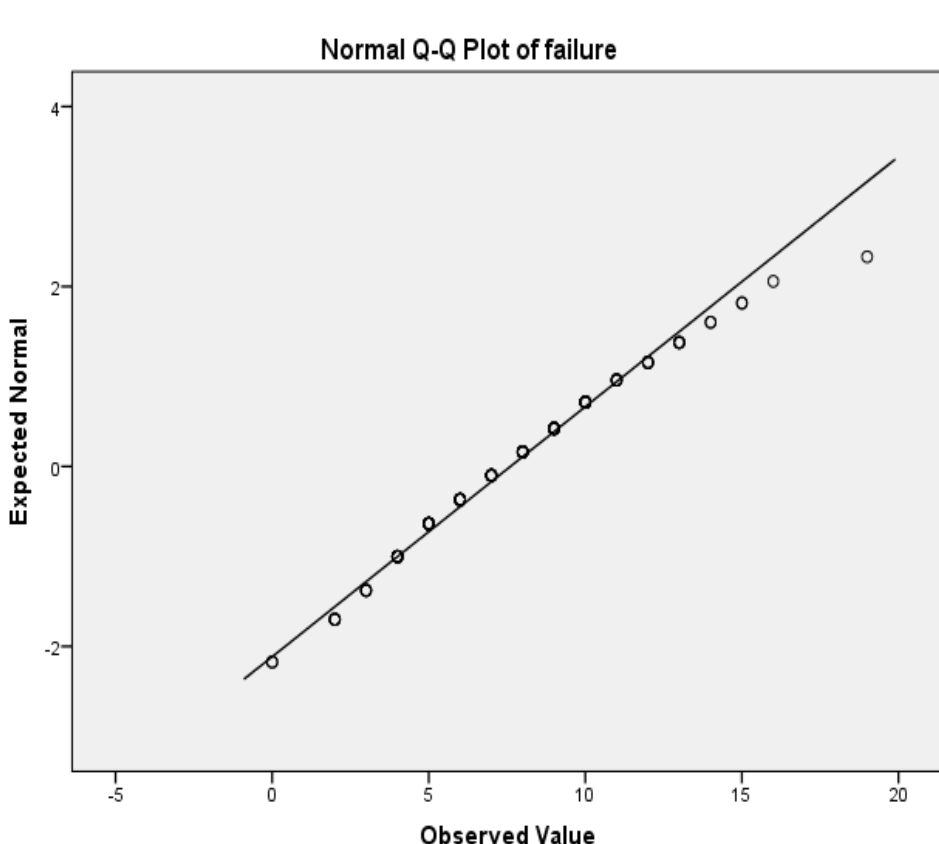
Figure 5. Q-Q plot for the number of Figure 5. Q - Q plot for the number of failures. Figure 5. Q - Q plot for the number of failures.